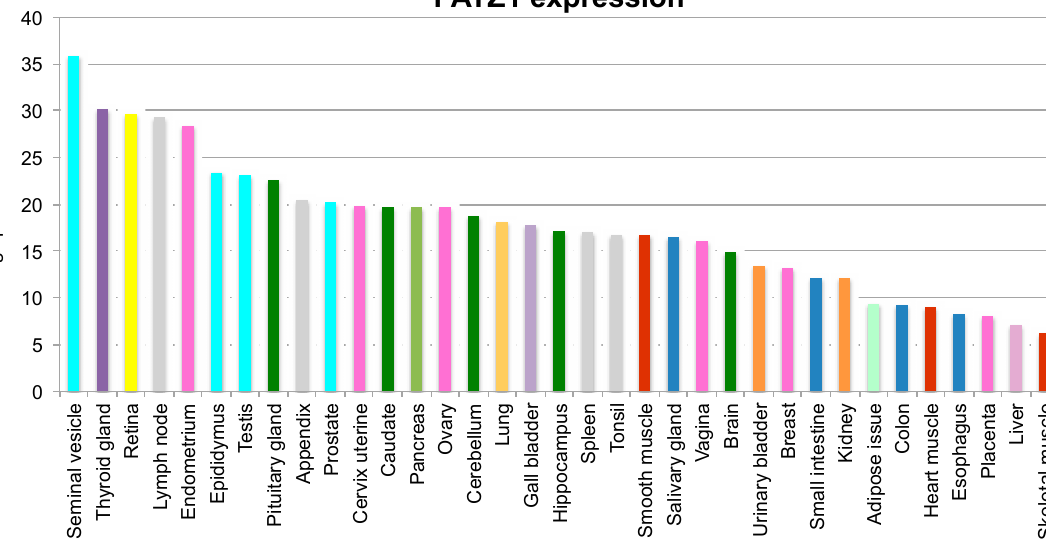
Figure 2. PATZ1 expression in human tissues. mRNA levels of PATZ1 in a panel of human tissues, obtained through Cap Analysis of Gene Expression (CAGE) by the FANTOM5 project [22]. The data have been extracted from the Human Protein Atlas [23]. PATZ1 is expressed at variable levels in all tissues.